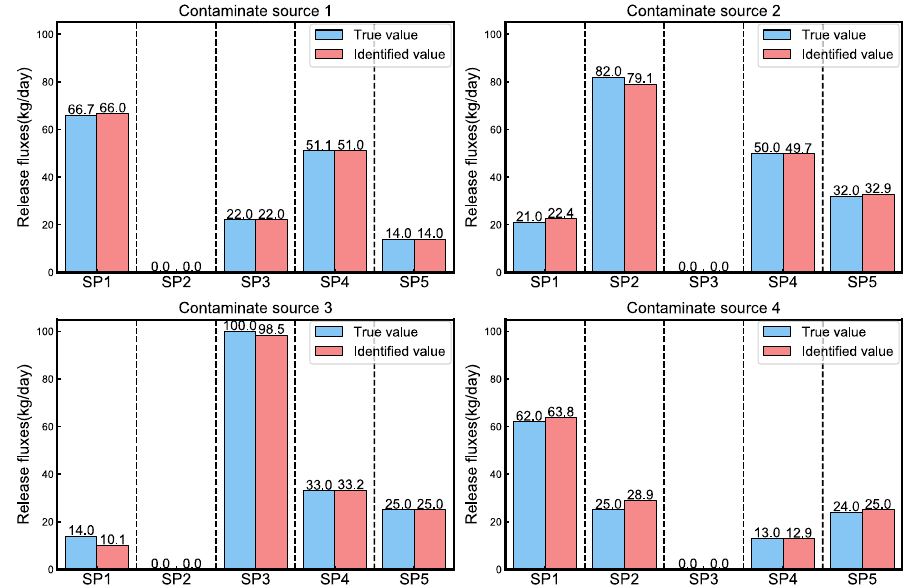
Figure 10. The comparison of identified source fluxes which obtained the best response value with actual fluxes.